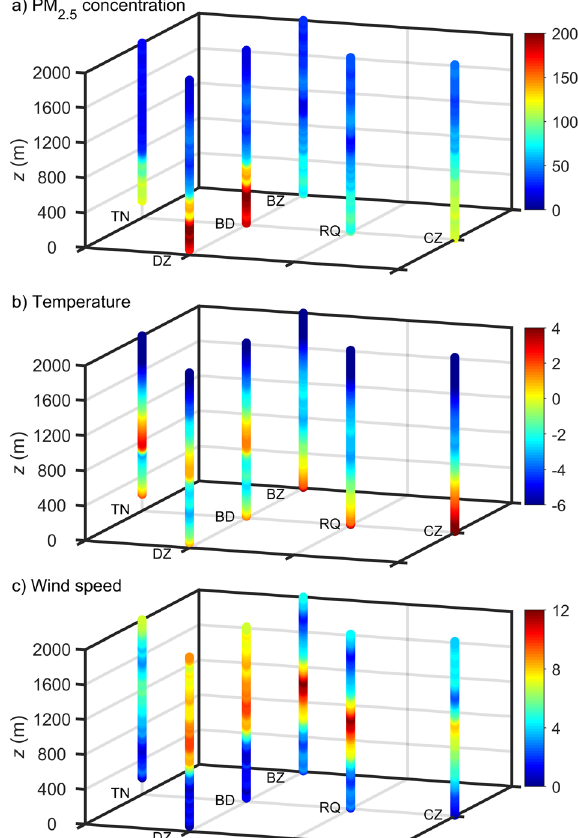
Fig. 6 Spatial distributions of air pollutants and the correspond- ing regional ABL structure at 14:00 LT on 30 November 2019. a PM 2 : 5 concentration (unit: μ g m − 3 ), ( b ) temperature (unit: ˚ C), ( c ) wind speed (unit: ms − 1